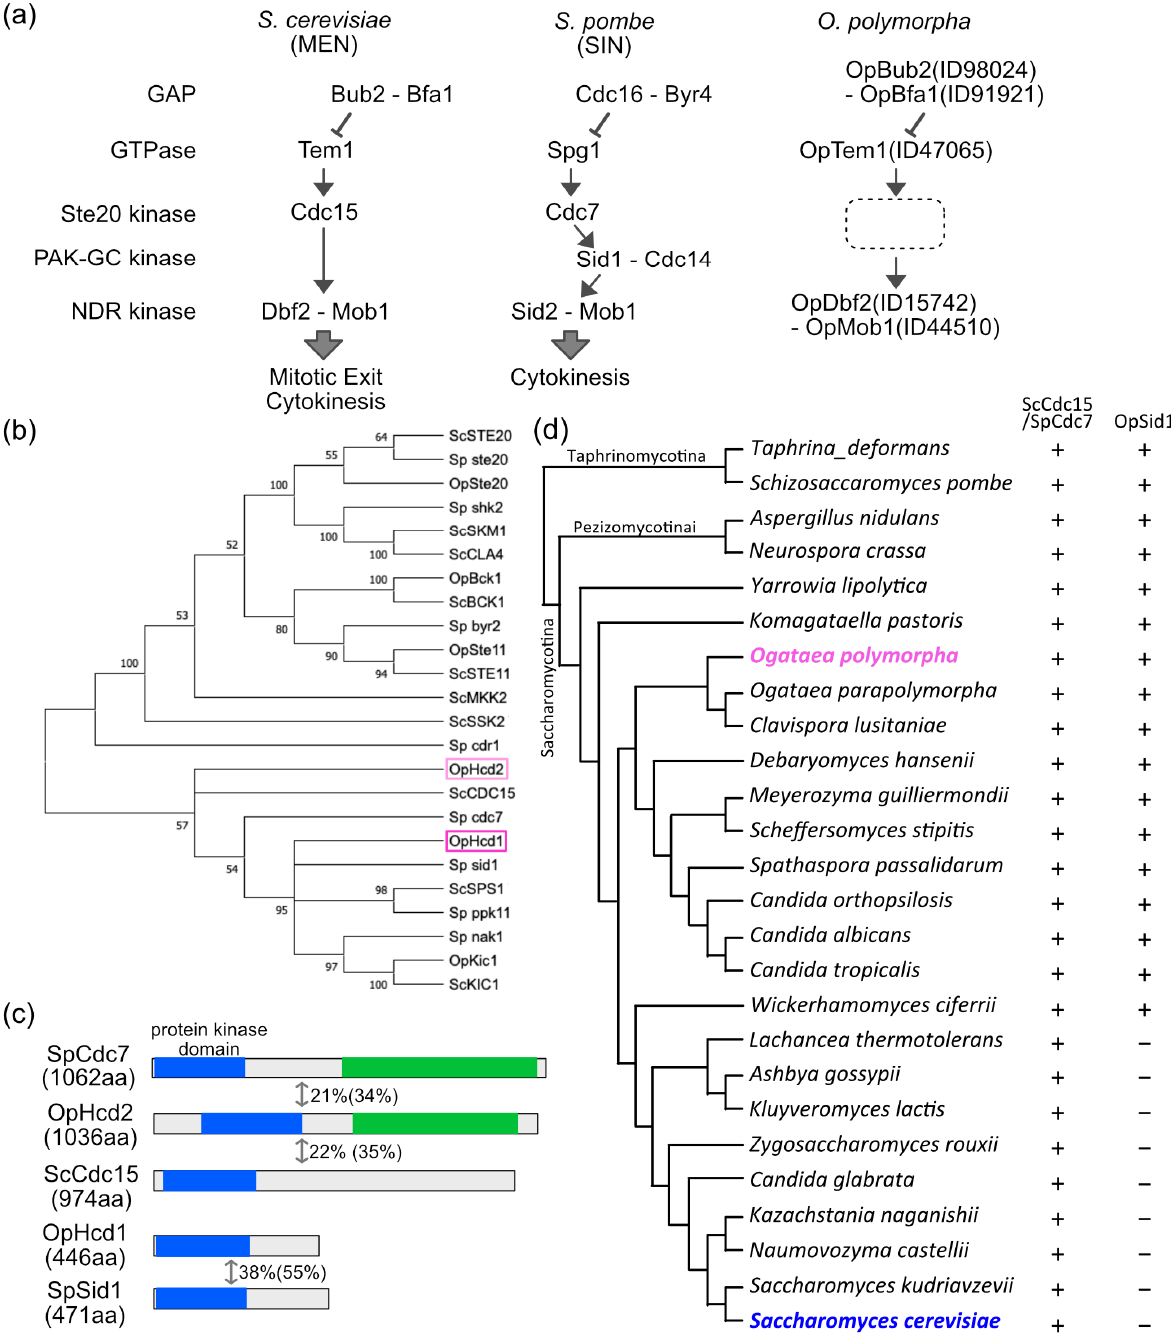
Figure 1. OpHCD1 and OpHCD2 encode protein kinases homologous to Sid1 and Cdc7 in S. pombe . ( a ) Schematics of the core components of the MEN and SIN and the homologous pathway in O. polymorpha . The protein IDs for O. polymorpha proteins are according to reference [6]. ( b ) Phylogenetic tree of protein kinases from S. cerevisiae , O. polymorpha , and S. pombe that have similarity with S. cerevisiae Cdc15. Phylogenetic tree was constructed in MEGAX with the Maximum Likelihood Method. Shown is the Bootstrap Consensus Tree. ( c ) Schematic representation of the OpHcd1, OpHcd2, ScCdc15, SpCdc7, and SpSid1 proteins. Blue and green boxes are the protein kinase domain and the armadillo type fold, respectively. The numbers are the amino acid identity and the similarity (in bracket) from the alignment between two kinases across the length of the proteins. ( d ) Conservation of ScCdc15/SpCdc7 and SpSid1 in Ascomycota. Phylogenetic relationships are based on Shen et al. [7] Tree is not in